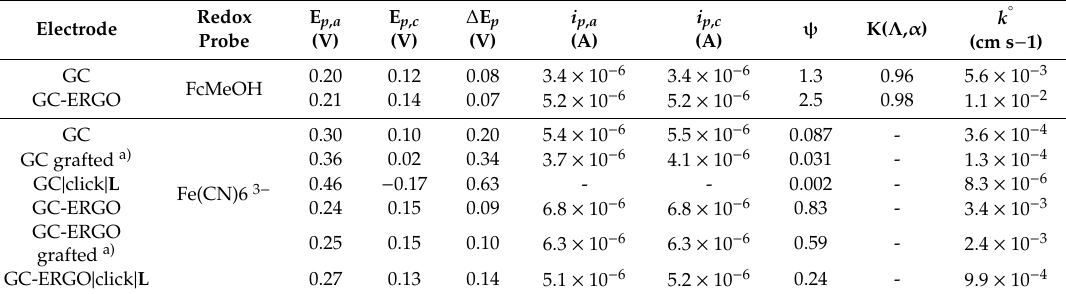
Table 1. Electrochemical parameters determined from cyclic voltammograms recorded in 0.5